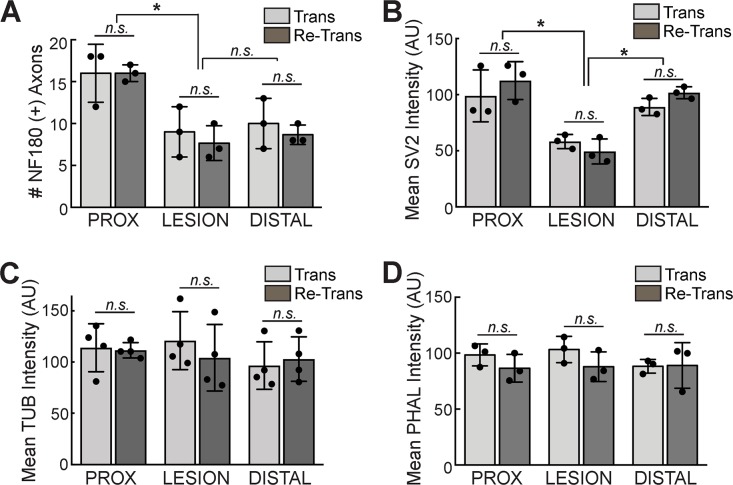
Quantification of NF-180, SV2, tubulin, and phalloidin staining reveals no significant differences after spinal re-transection.(A) Though there was a decrease in the number of NF-180 (+) axons within and distal to the lesion, compared to proximally, no differences were observed between transected and re-transected spinal cords at all locations. (B) Similarly there were no differences in the SV2 immunofluorescence intensity in transected and re-transected spinal cords, though the signal was reduced within the lesion. (C-D) Tubulin and phalloidin staining show similar levels of microtubule and F-actin throughout the spinal cord in transected and re-transected animals. AU = arbitrary units. Data represents mean ± SD from n = 3–4 experiments. * indicates p<0.05 by ANOVA. n.s. = not significant.